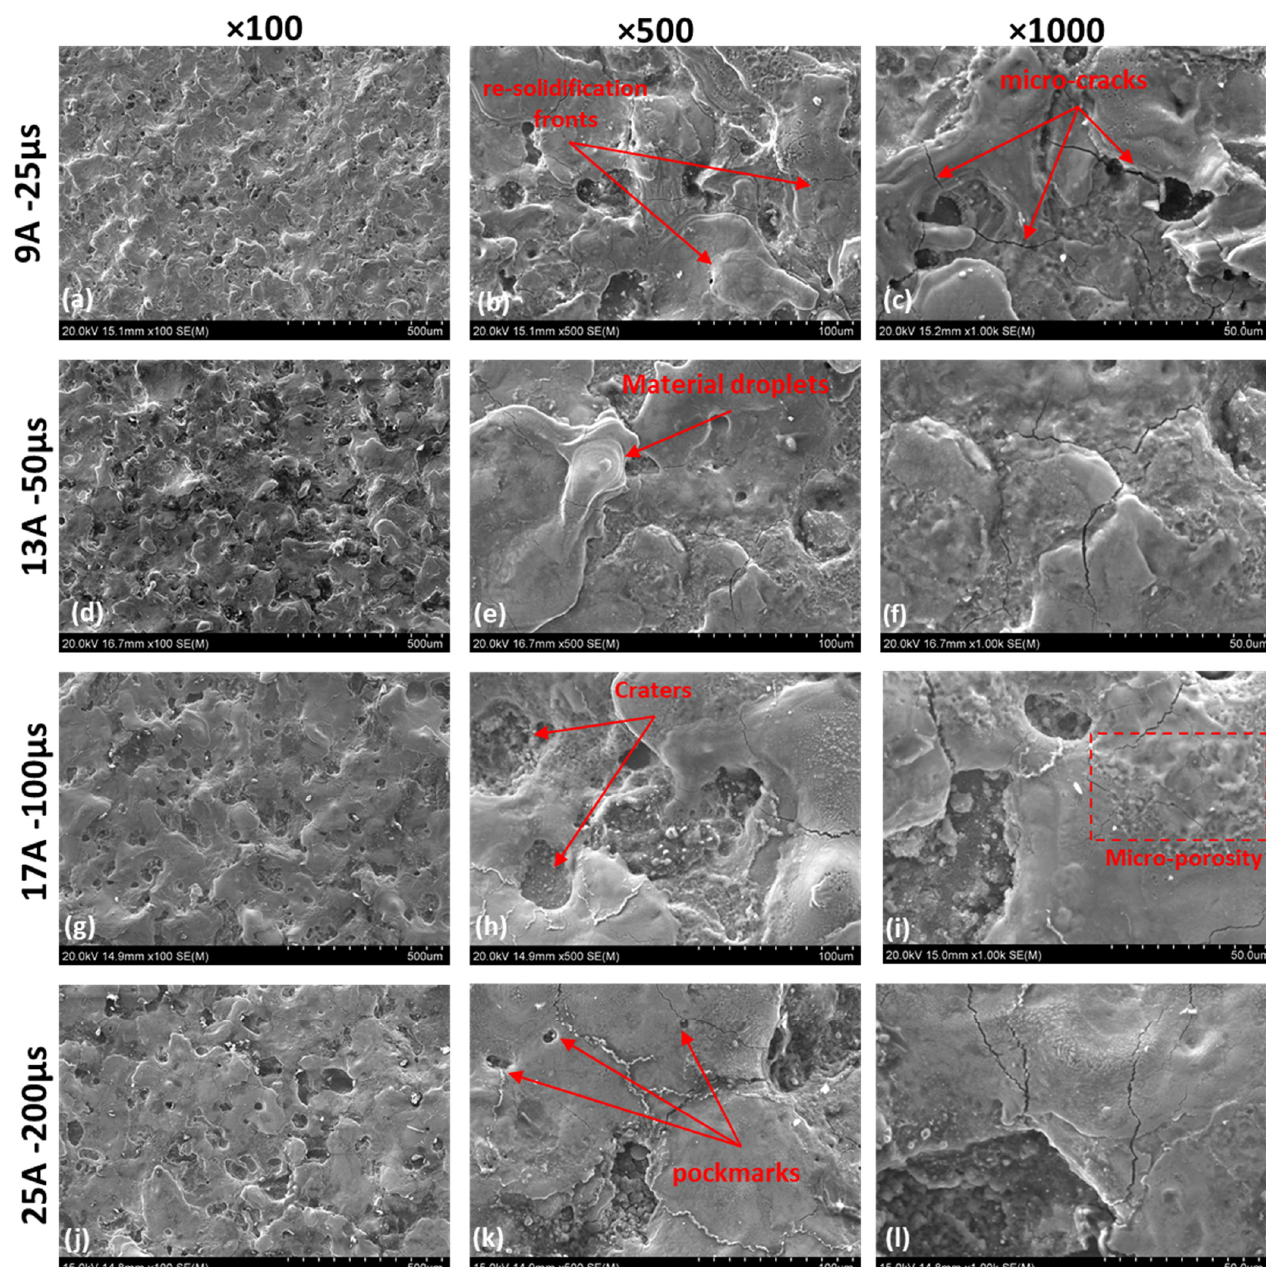
Figure 10. SEM images illustrating the workpiece surface in different magnification and machining parameters. For ( a – c ) 9 A—25 µs, ( d – f ) 13 A—50 µs, ( g – i ) 17 A—100 µs, and ( j – l ) 25 A—200 µs machining